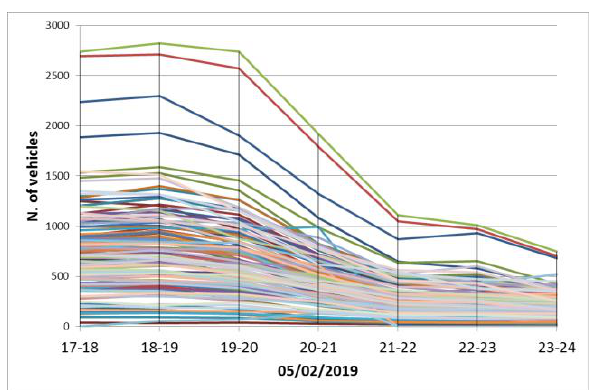
Figure 8. Comparison between the mean of standardised values